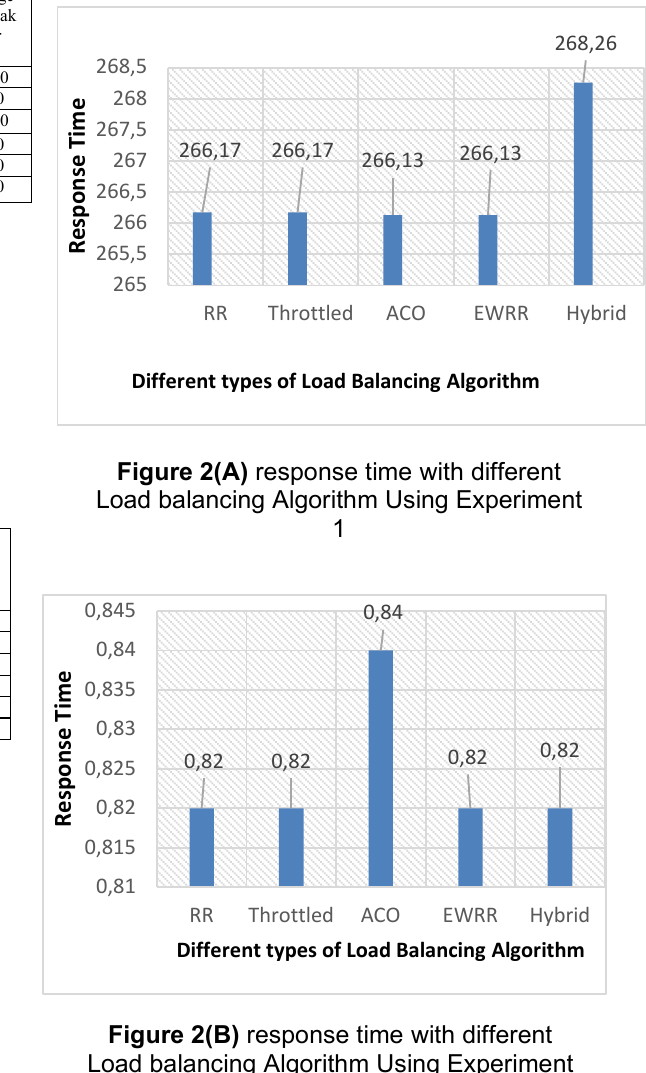
Figure 2(B) response time with different Load balancing Algorithm Using Experiment